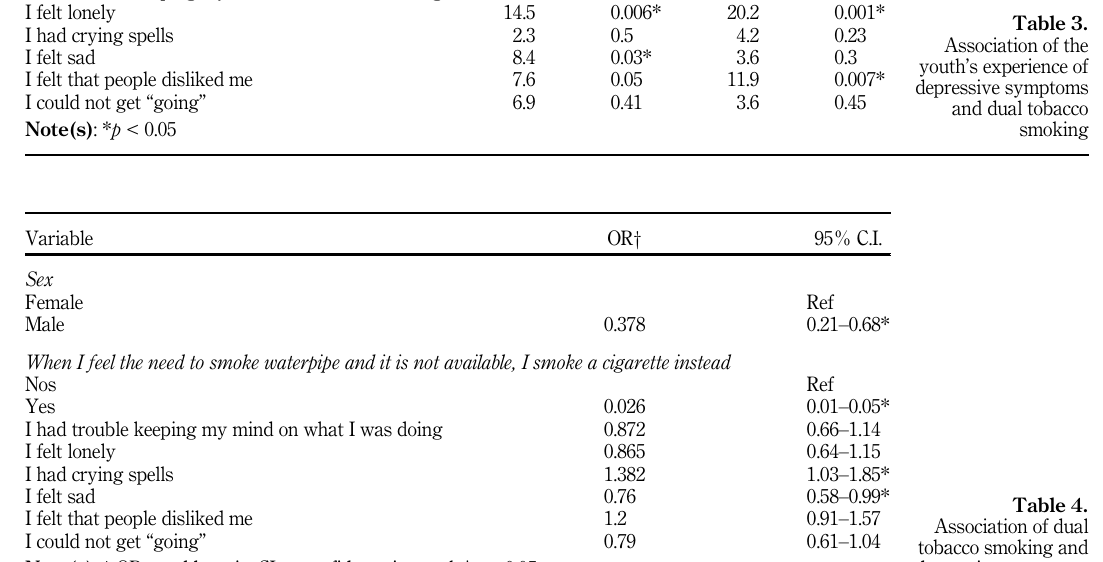
Table 3. Association of the